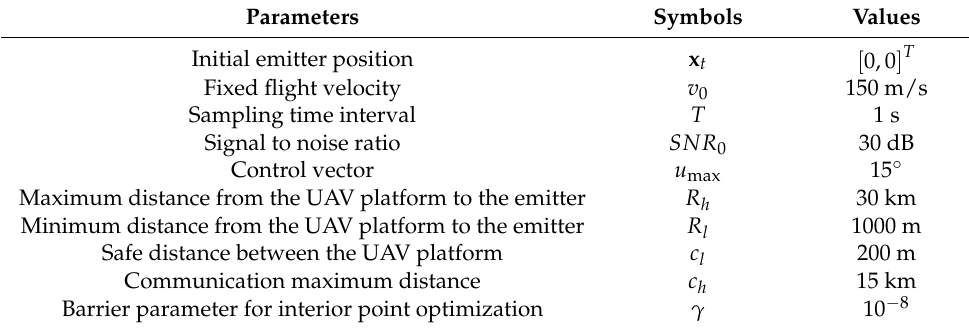
Table 1. Parameters used in simulations.